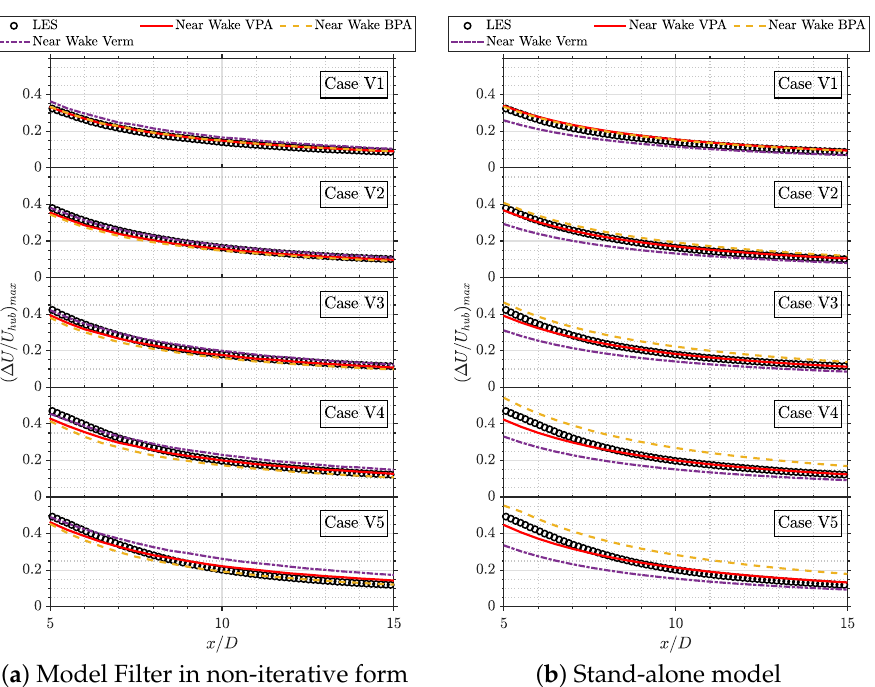
Figure 9. Normalized maximum velocity deficit as a function of streamwise distance: a comparison of the effect of different near-wake relations on the analytical model outputs. ( a ) Model Filter in non-iterative form with different near-wake length relations; ( b ) stand-alone model with different near-wake length